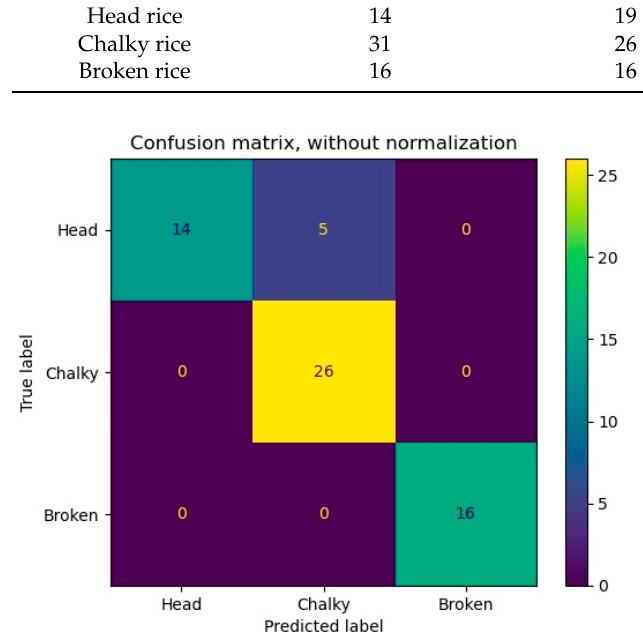
Figure 11. Confusion matrix of rice grain types before improvement.